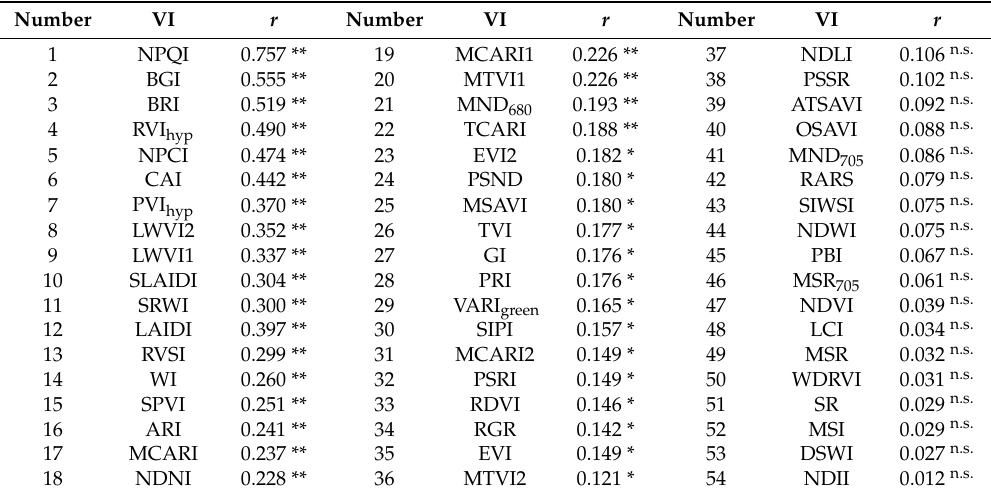
low correlated with other VIs. Among the top 22 VIs, a low correlation (zone a) was observed, but the remaining 32 VIs have a high correlation (zone b). The VIs analysis results of total explained variance and variance inflation factor (VIF) values are shown in Tables A1 and A2 (in Appendix